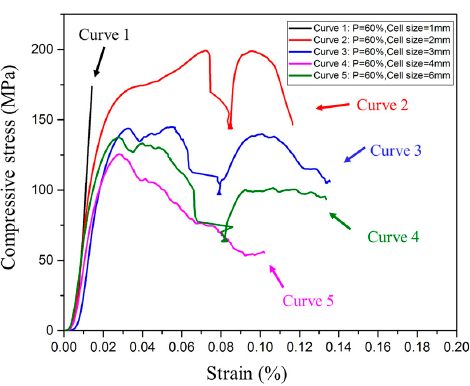
Figure 10. Compressive stress-strain curve of porous structures with a porosity of 60% and different unit cell sizes.